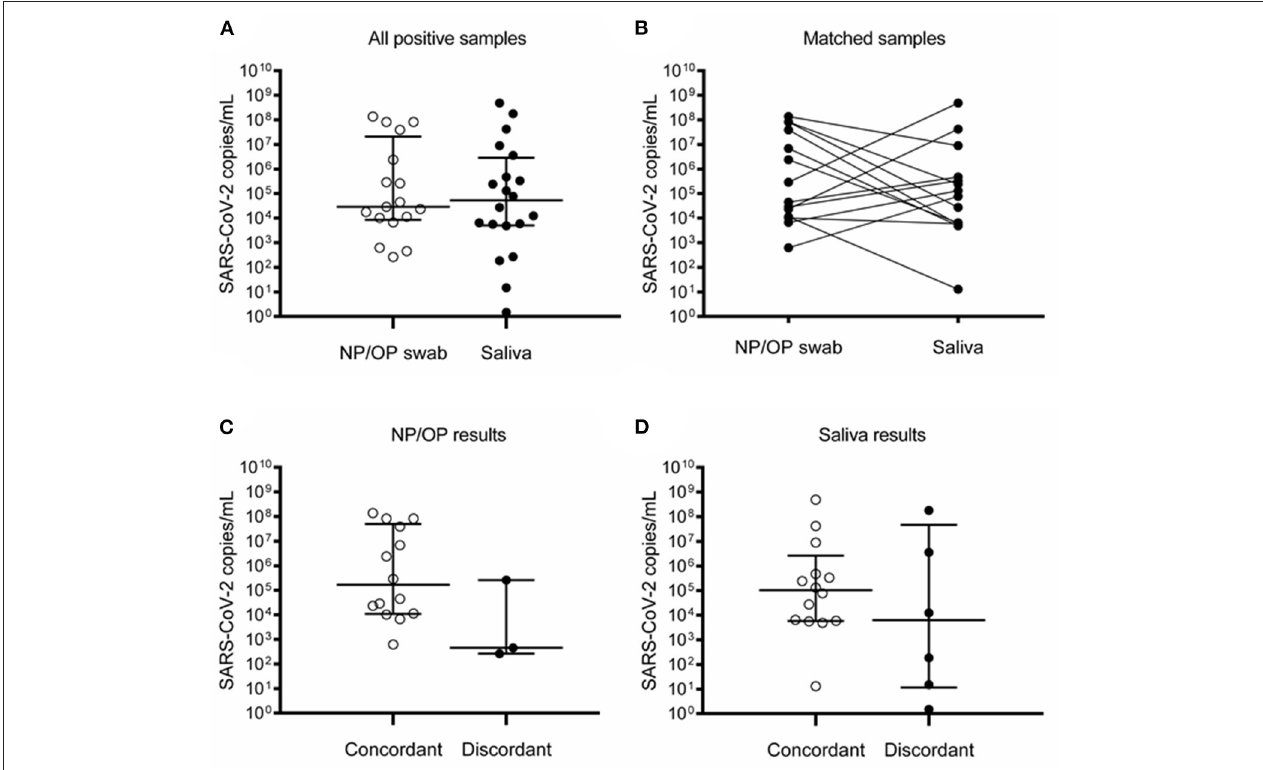
FIGURE 4 | Detection of SARS-CoV-2 in NP/OP swabs and saliva of children and adolescents. (A) All positive samples in NP/OP swab ( n = 17) and saliva ( n = 20) ( p = 0.6565), bars represent median and 25–75 percentiles. (B) Matched samples ( n = 14) ( p = 0.5093). (C) Viral loads of concordant ( n = 14) and discordant ( n = 3) NP/OP swab samples ( p = 0.0924). (D) Viral loads of concordant ( n = 14) and discordant ( n = 6) saliva samples ( p = 0.2542). Data in (A,C,D) were compared with Mann–Whitney test. Data in (B) were compared with Wilcoxon